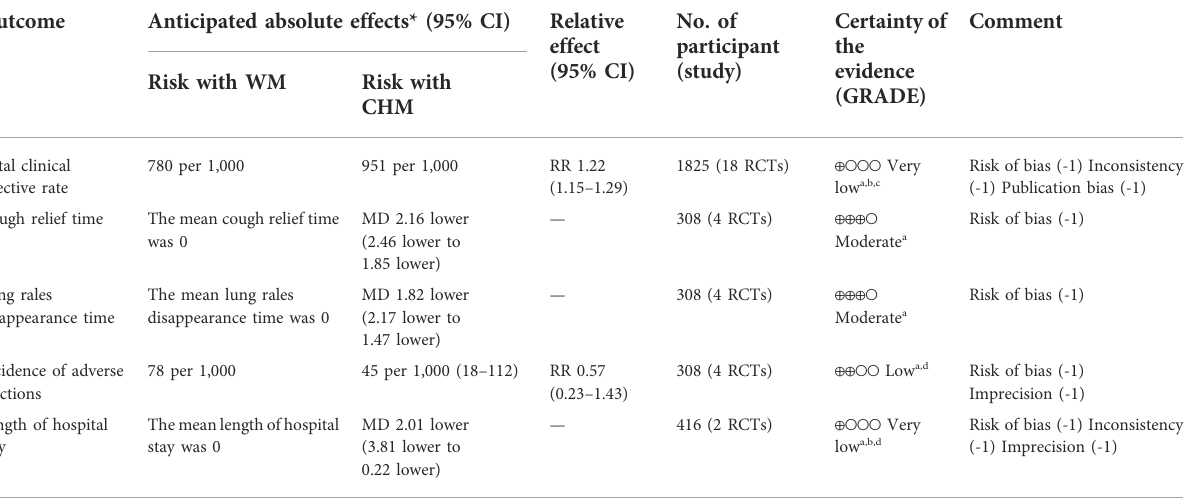
TABLE 2 Quality of evidence by